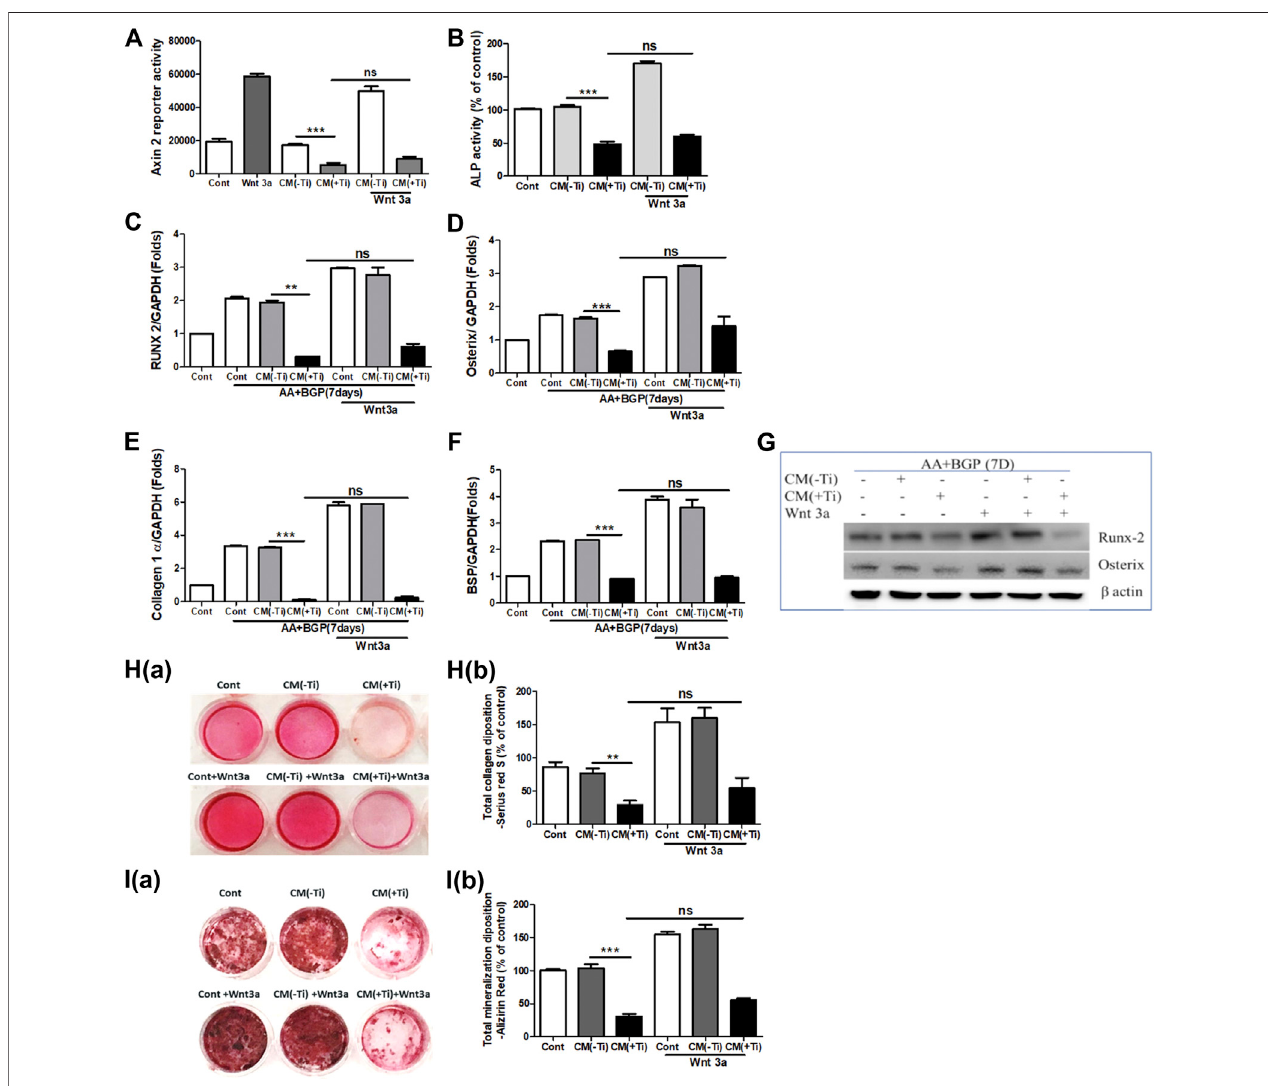
FIGURE5| TiCMinhibitsosteogenicinductionafterstimulationofosteoblastsbyexogenousWnt3a.TheSaOS-2cellwaspre-incubatedwiththeTiCMfor30 min andthereafterstimulatedwithrecombinantWnt3aalongwiththeTiCM. (A) CelllysatesfromTiCM – treatedSaOS-2cells(Axin-2reporterconstructtransfected)for24 h werecollected,andreporteractivitywasanalyzed. (B) ALPassaywasperformedafter48 hoftreatment. (C – F) SaOS-2cellsweregrownunderdifferentiationconditions as described in Materials and Methods for 7 days (D) and then treated with 100% Ti CM for 24 h. Relative mRNA expressions of Osterix, Runx2, collagen 1 α , and BSP were evaluated by real-time PCR. The results shown are normalized to GAPDH levels. (G) Protein expressions of Runx2 and Osterix were analyzed by SDS gel electrophoresis. β -Actin is used as a loading control. (H) Collagen synthesis and ( I ) mineralization were evaluated after 14 days of treatment, by Sirius Red and Alizarin Red S staining, respectively. Collagen deposition depicted as (H(a)) gross appearances. (H(b)) Quantitative analysis of Sirius Red S staining. The effect of Ti CM on mineralizationisdepictedas (I(a)) grossappearances. (I(b)) Quantitative analysisofAlizarinRed Sstaining.Dataareshown asmean ± SD.Similarresults wereobtained in three independent experiments. * p < 0.05, ** p < 0.01, *** p < 0.001, and ns (no signi fi cance) vs.